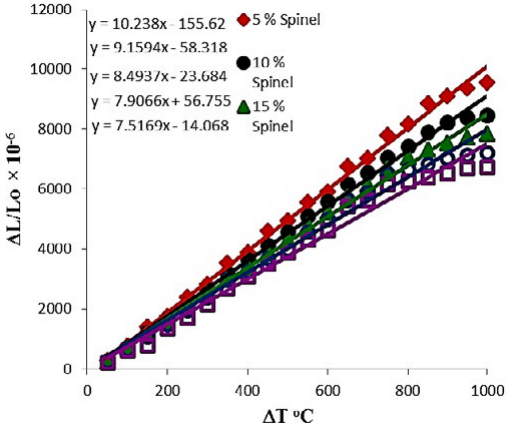
Fig. 5. Curves compare the thermal expansion for Y-PSZ with different MAS